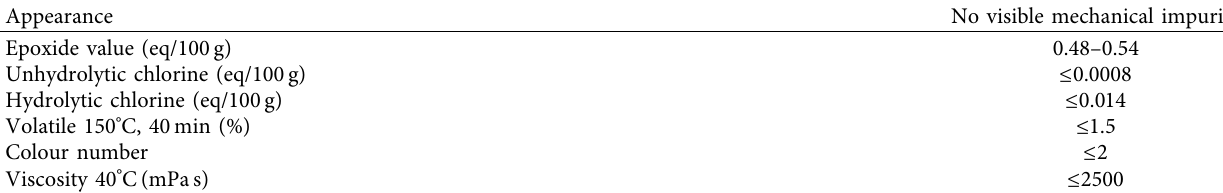
Figure 1: Raw materials for producing the interface-bonding material: (a) E-51; (b) T-31. Table 1: Basic parameters of E-51.